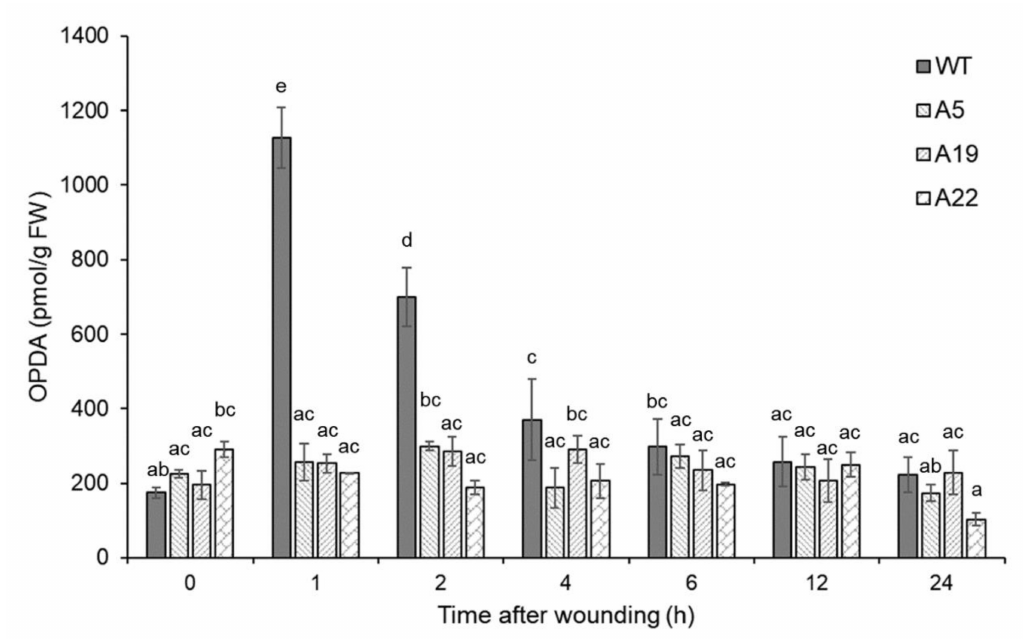
Figure 1. Accumulation of 12-oxo-phytodienoic acid (OPDA) in P. patens after wounding. The wild-type and aos mutants of P. patens were grown on BCDAT agar for 3 weeks and then treated with wounding. The samples were prepared at 1, 2, 4, 6, 12, and 24 h after wounding. Three independent experiments were conducted as biological replicates. The concentrations of OPDA in the wild-type and aos mutants (A5, A19, and A22) after wounding were analyzed using ultra-performance liquid chromatography-tandem mass spectrometry (UPLC-MS / MS). The values are the mean ± SD ( n = 3). Di ff erent letters indicate that the change is significant as determined by one-way ANOVA according to Tukey’s multiple comparison test ( p <